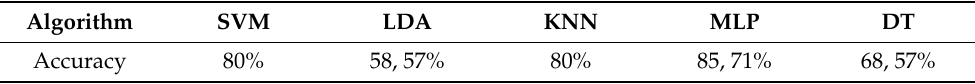
Table 8. The results of the accuracy comparison of the classification approaches.